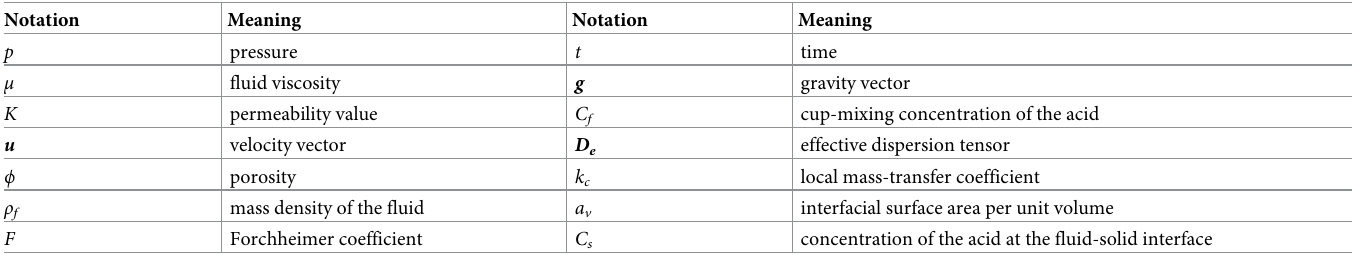
Table 1. The meanings of the